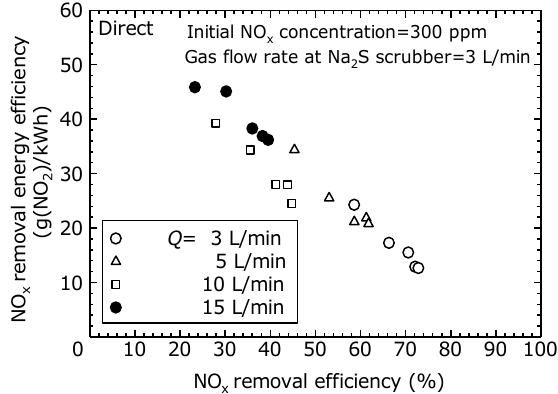
Figure 7. Measurement relation between NO x removal efficiency and NO x removal energy efficiency at different flow rate by the direct oxidation method. (The NO x removal energy efficiency is calculated as total flow rate Q = 3 – 15 L/min from the inflow rate of exhaust gas to the chemical scrubber of Q s = 3 L/min).